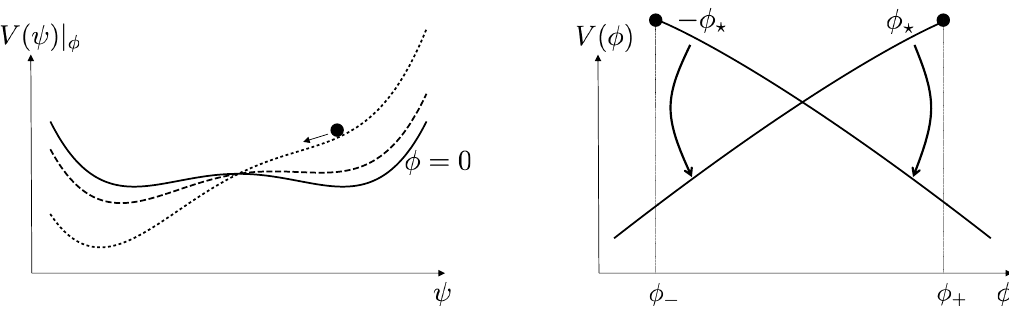
Figure 4 . Vacuum structure in the Landau model, where φ plays an analogous role to an external magnetic field. Left panel: V as a function of ψ for different values of φ . Right panel: V as a function of φ with ψ fixed at its two possible